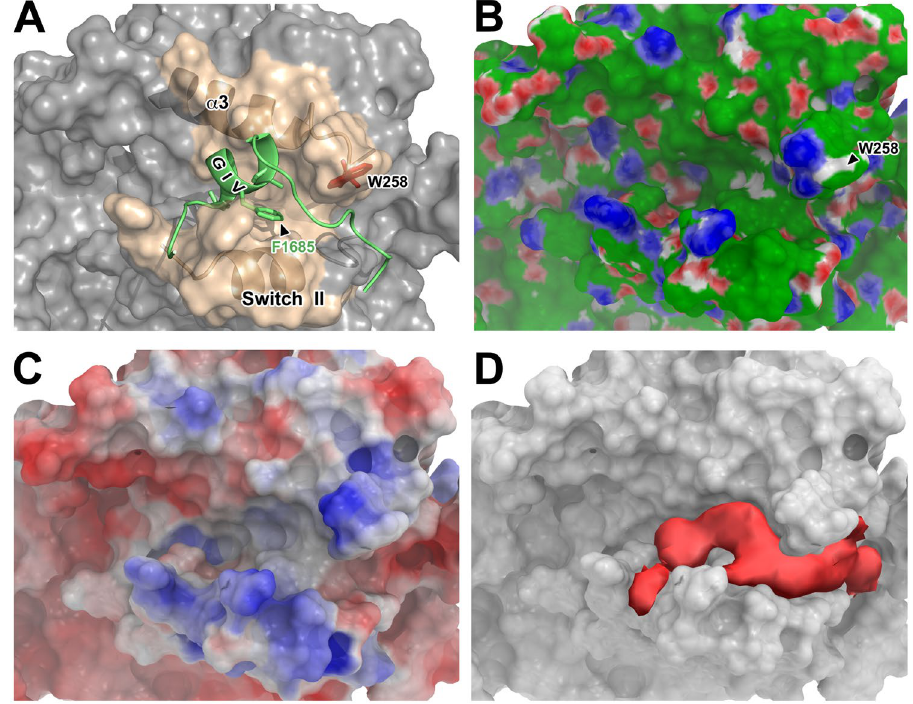
Figure 1. Computational prediction of a druggable site on the GIV binding region of G α i3. ( A ) A model of GIV (residues 1678–1696, green ribbon) bound to G α i3 (gray/beige surface) was built by homology modelling on the G α i1:KB-752 crystal structure (PDB: 1Y3A) and in silico protein-protein docking as described in Methods . The interaction primarily involves an amphipathic α -helix of GIV engaging a hydrophobic cleft on G α i3 (beige) formed by the α 3 helix and the Switch II region. ( B ) Physicochemical properties of the GIV binding site on G α i3. The same pose of the model as in ( A ) is shown displaying hydrophobic regions in green and hydrogen bond donors and acceptors in blue and red, respectively. GIV is not shown for the sake of clarity. ( C ) Electrostatic properties of GIV binding site on G α i3. The same pose of the model as in ( A ) is shown displaying positively charged regions in blue, negatively charged in red and neutral in grey. GIV is not shown for the sake of clarity. (D) Predicted druggable pocket (red) on G α i3 (gray). The pocket capable of accommodating small molecules was identified in the model depicted in ( A ) as described in Methods